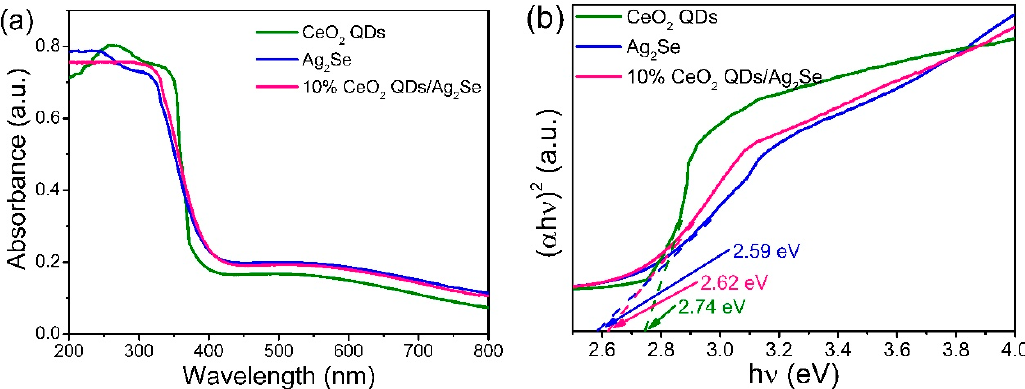
Figure 7. ( a ) UV-visible absorption spectra of CeO 2 QDs , Ag 2 Se, and 10% CeO 2 QDs/Ag 2 Se and ( b ) plots of ( α h ν ) 2 versus bandgap ( h ν ) of CeO 2 QDs , Ag 2 Se, and 10% CeO 2 QDs/Ag 2 Se.